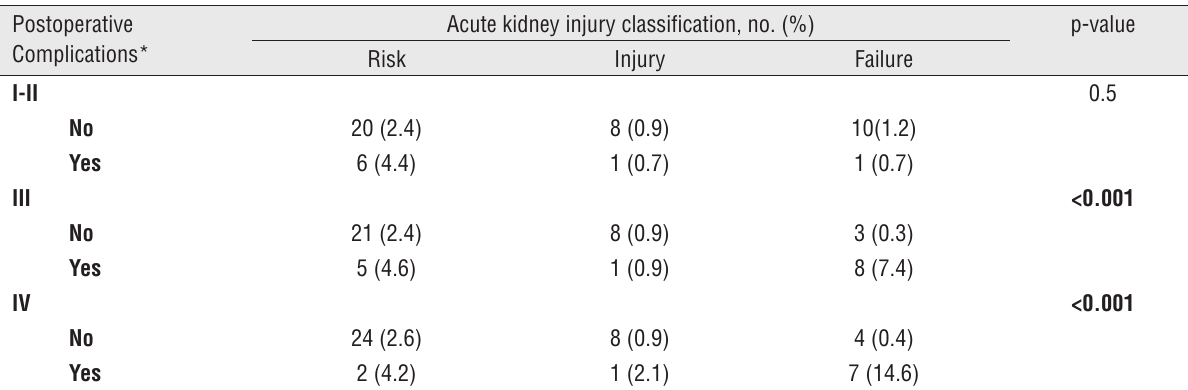
Table 3 – Association between postoperative complications and the various stages of acute kidney injury after radical cystectomy.